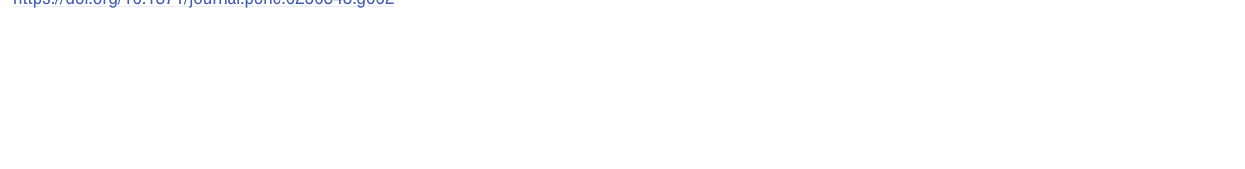
PLOS ONE | https://doi.org/10.1371/journal.pone.0250348 April 23, 2021 7 /